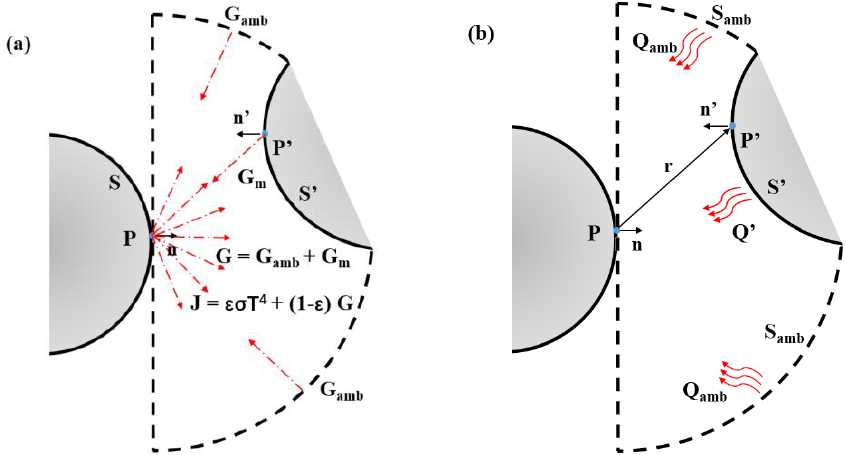
Figure 4. Radiation model between surfaces. ( a ) Incident radiation and outgoing radiation. ( b ) View factor evaluation between surfaces.